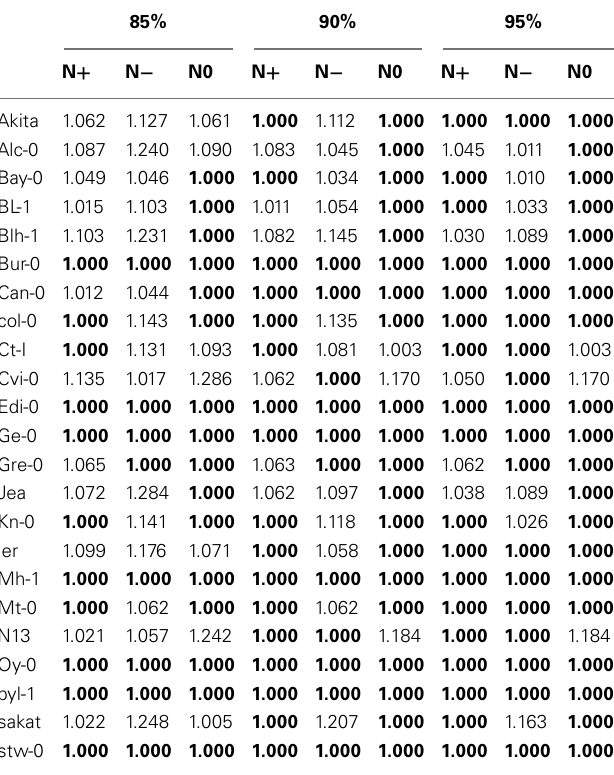
Table 2 | Efficiency values for the accessions obtained from PCA-DEA with 85, 90, and 95% of variance